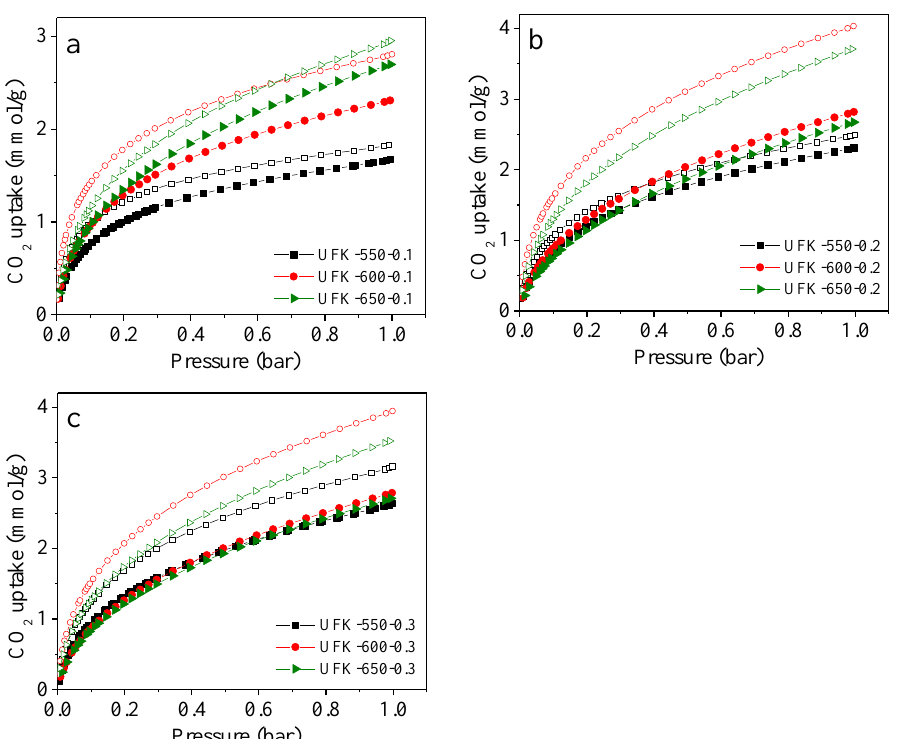
Molecules 2022 , 27 , x FOR PEER REVIEW Figure 5. CO 2 adsorption isotherms at 25 ◦ C (filled) and 0 ◦ C (empty) for urea formaldehyde resin-derived N-doped carbons prepared under KOH/UF mass ratio of ( a ) 0.1, ( b ) 0.2 and ( c ) 0.3.